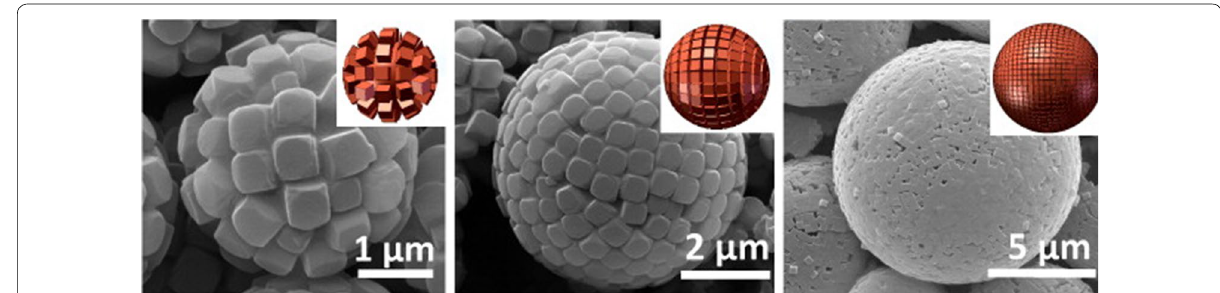
Fig. 1 SEM images of colloidosomes formed from cubic Fe-soc-MOF building blocks (Reprinted with permission from Ref [29]. Copyright 2013 American Chemical